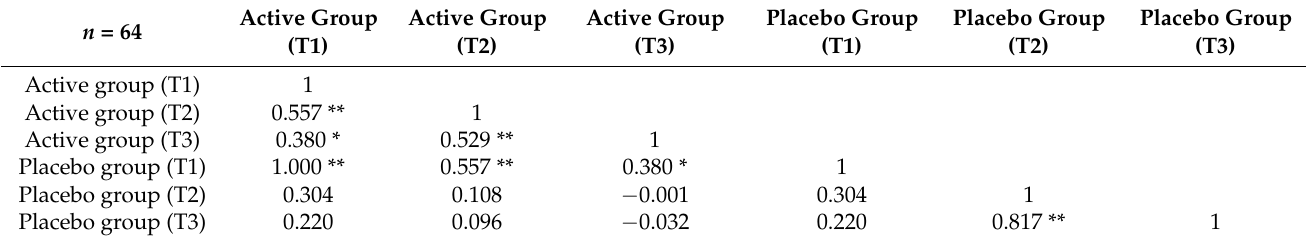
Table 3. Spearman correlation of active group and placebo group over a period of T1, T2, and T3 intervals.